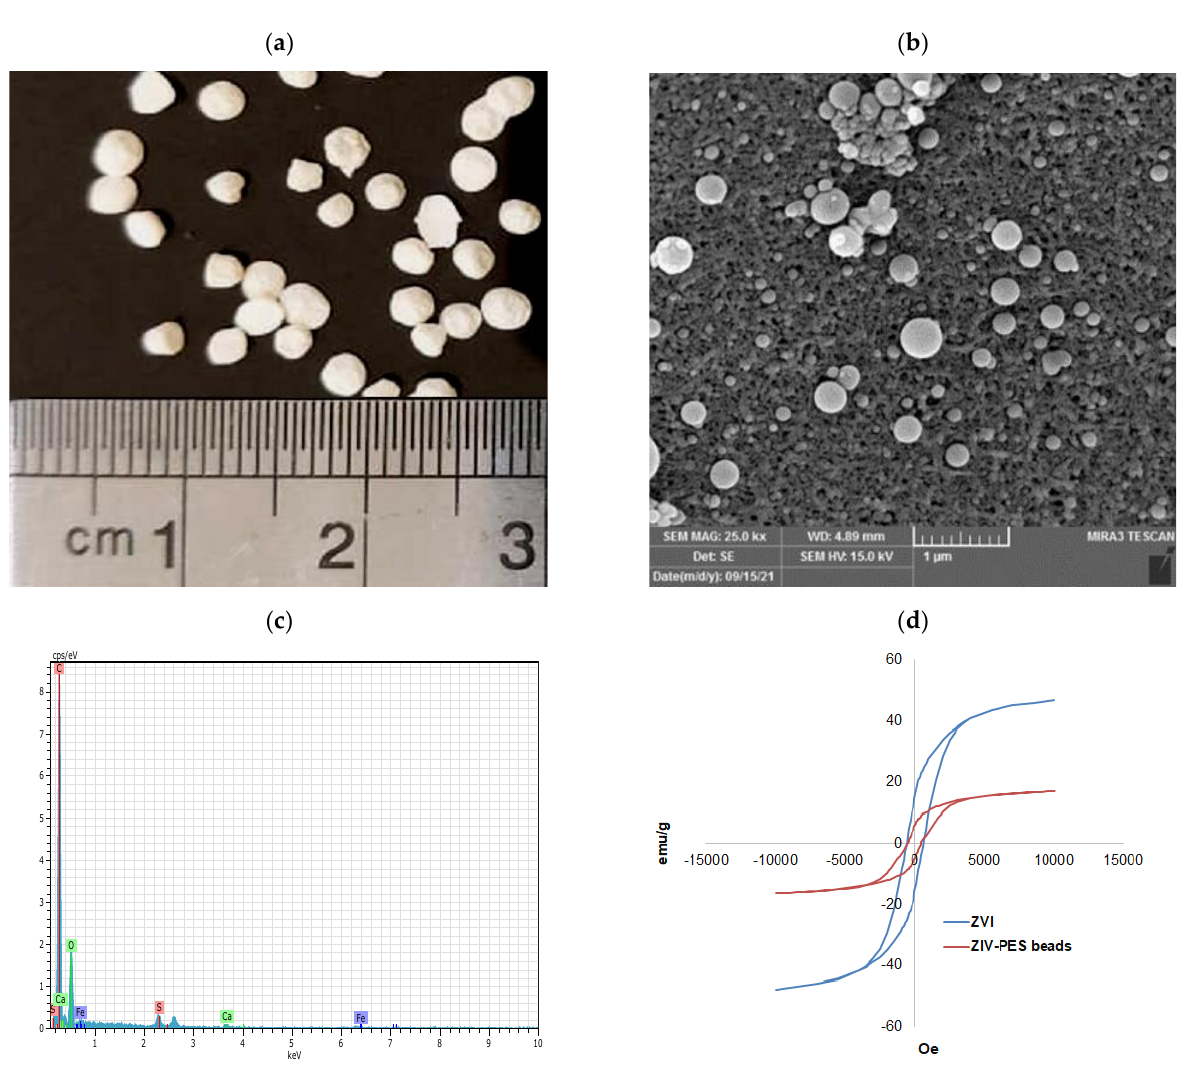
6 of 17 Figure 3. TGA curves of plain PES and PES/ZVI beads. 3.1.3. SEM Microscopy The characterization of the surface of the PES/ZVI beads was measured by a scanning electron microscope (SEM). Figure 4a shows the digital photograph of the PES/ZVI beads with spherical shapes with smooth and uniform surfaces and in the range of 1 – 3 mm. With increasing the magnification, the SEM images (b) confirmed the distribution of ZVI nano- particles on the surface of the PES beads. To better understand, the magnifying surface of the adsorbent provides direct visual evidence of the PES/ZVI beads, and sponge-like pores are present with a high dispersity of ZVI on the surface of the PES polymer. These sponge- like pores were interconnected with each other and with the nanometric surface pores. This property could significantly enhance the porosity and surface-to-area ratio, resulting in a high potential to capture arsenic ions [17,18].